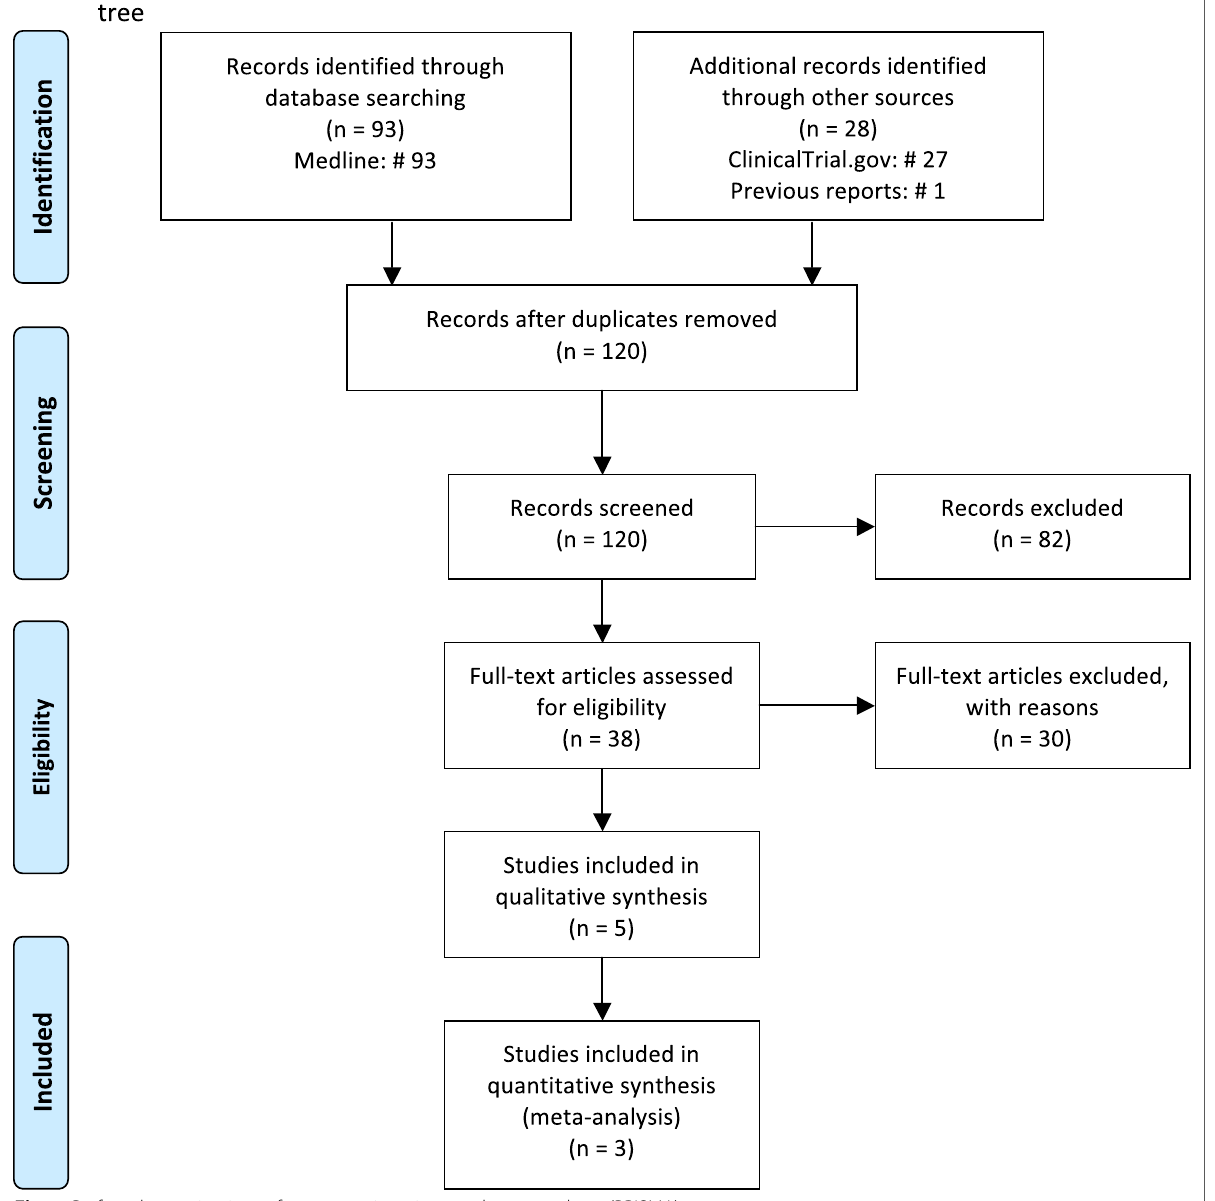
Fig. 1 Preferred reporting items for systematic reviews and meta-analyses (PRISMA)